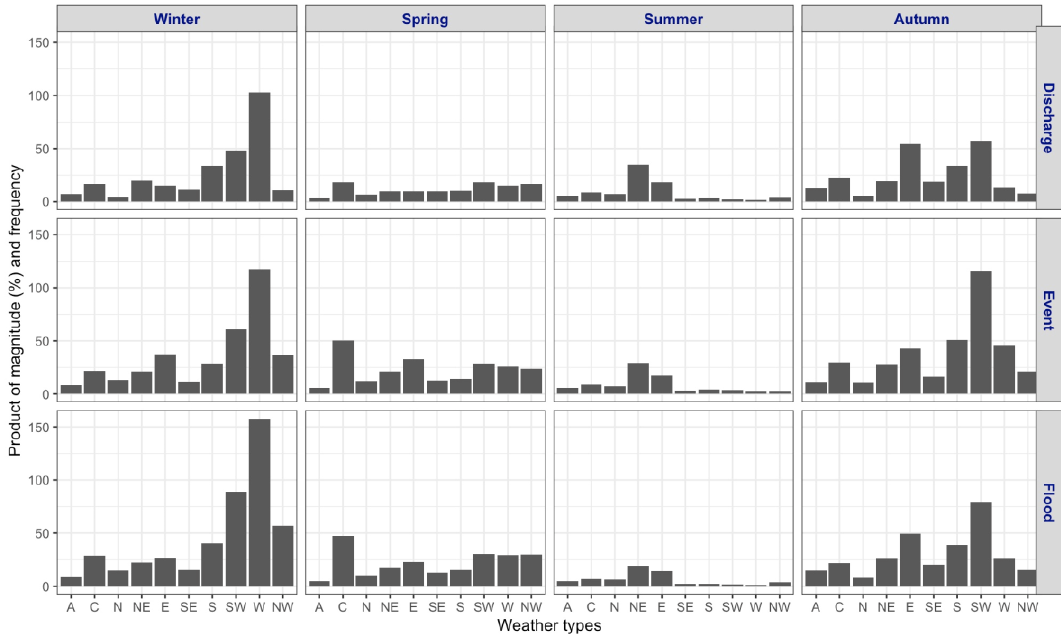
Figure 7. Efficiency index calculated by the product of magnitude (%) and frequency of the seasonal rainfall, runoff, and sediment yield for the different weather types.